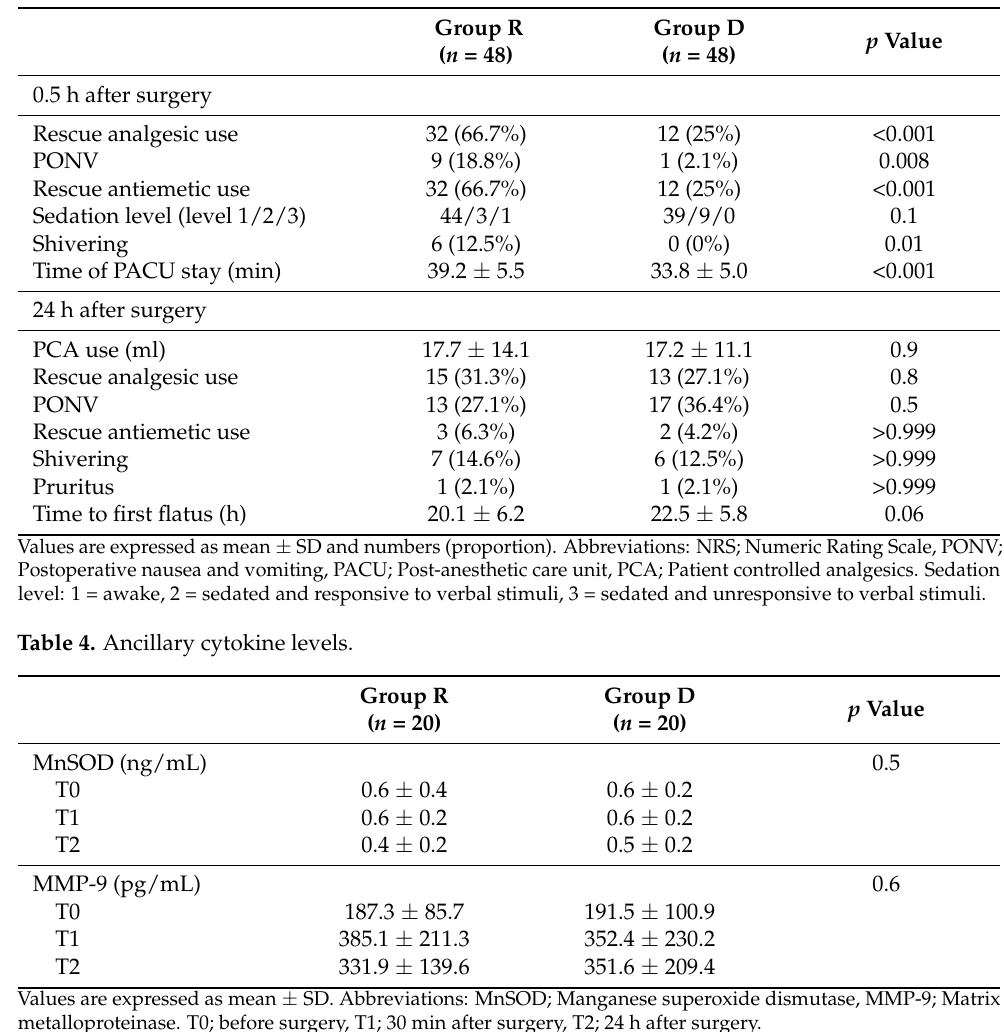
Table 3. Postoperative findings.